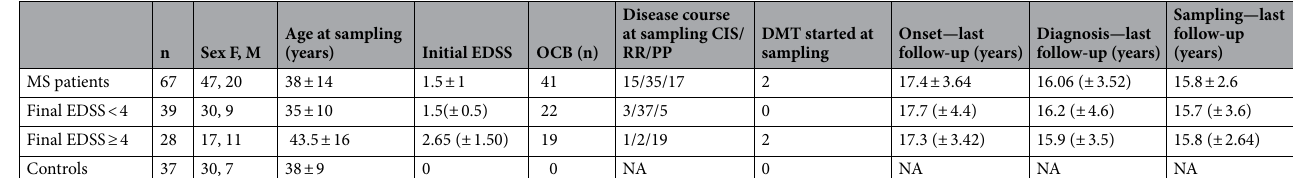
Table 1. Baseline demographic and clinical data of patients and controls. All ages, years and EDSS scores quoted as median ± IQR M male, F female, EDSS Expanded Disease Disability Scale, OCB oligoclonal